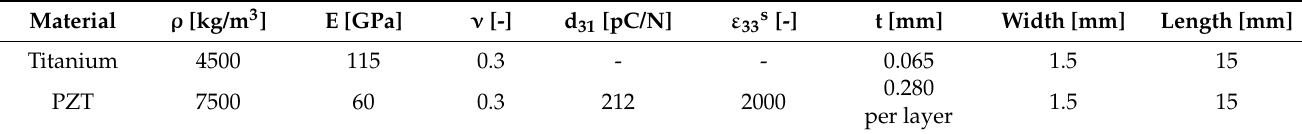
Table 1. Physical parameters and dimensions of the piezoelectric beam.